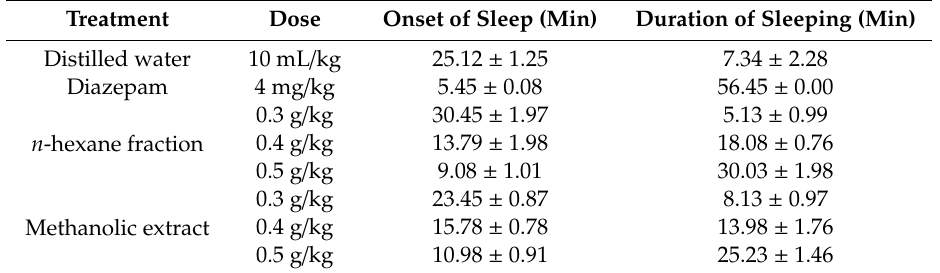
Table 4. E ff ect of methanolic extract and n-hexane fraction on phenobarbitone-induced sleep in mice. Treatment Dose Onset of Sleep (Min) Duration of Sleeping (Min) Distilled water 10 mL / kg 25.12 ±